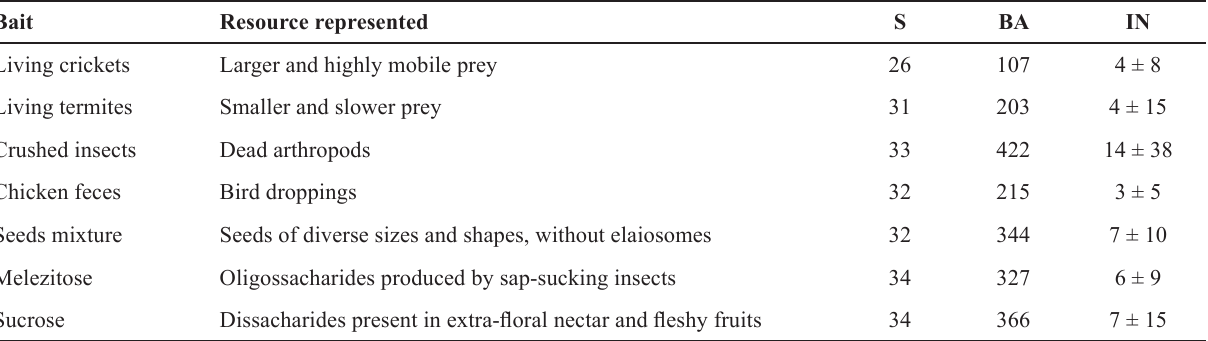
Table 1 – Baits used to represent natural resources in this work, with total number of species (S), records (BA) and average number of individuals ± S.D. (IN) recorded. Bait Resource represented Living crickets Larger and highly mobile prey Living termites Smaller and slower prey Crushed insects Dead arthropods Chicken feces Bird droppings Seeds mixture Seeds of diverse sizes and shapes, without elaiosomes Melezitose Oligossacharides produced by sap-sucking insects Sucrose Dissacharides present in extra-floral nectar and fleshy